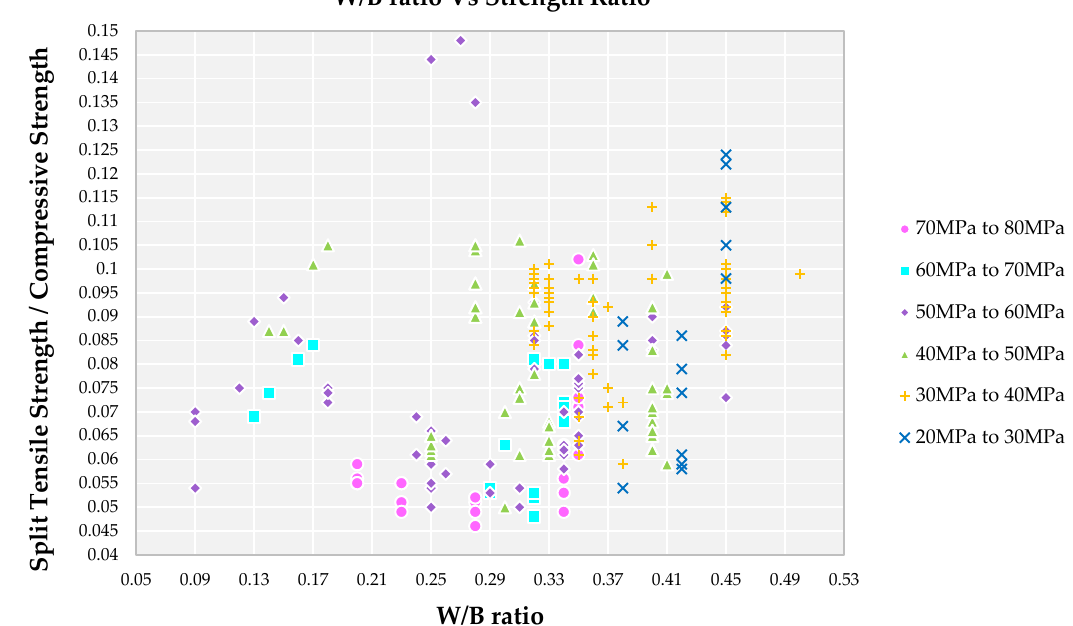
Figure 4. Impact of W/B ratio on split tensile strength to compressive strength ratio for different grades of SCC concrete with recycled aggregate according to literature.